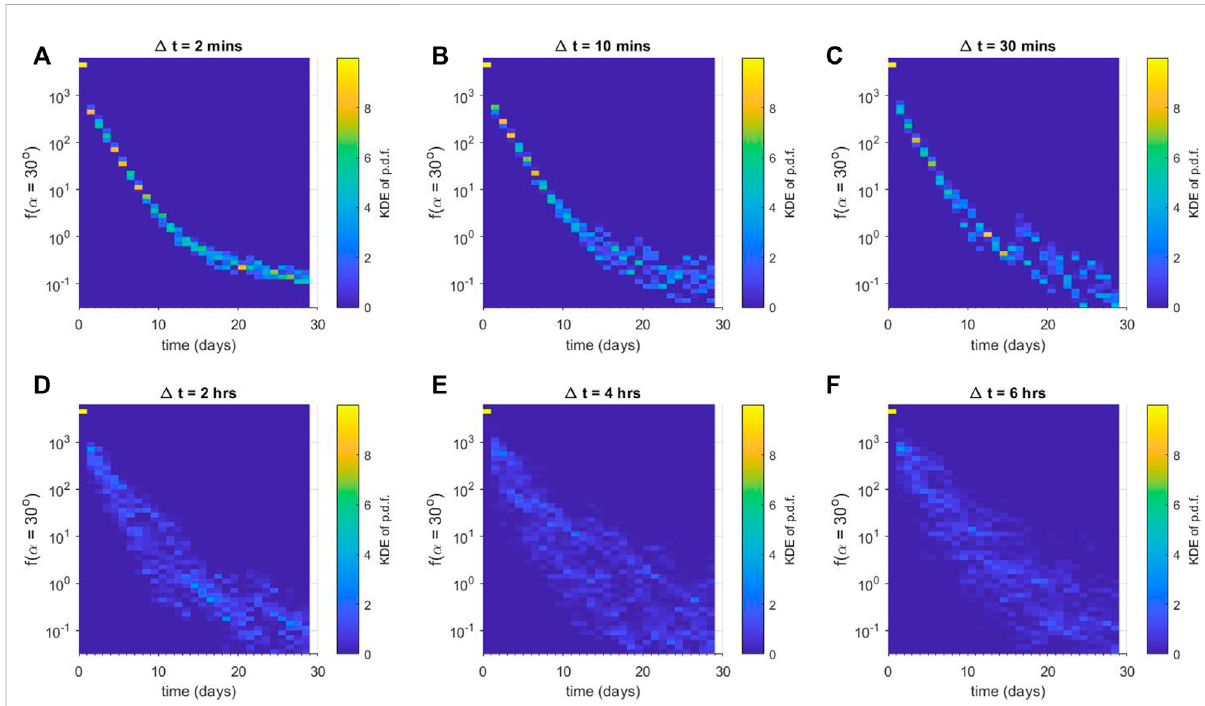
FIGURE 3 Ensembleresultsfornumericaldiffusionexperimentsusing D αα ( L *=3).Eachpanelshowsacolumn-normalisedprobabilitydistributionfunction forthephasespacedensity f justoutsidetheloss-cone α LC for (A) Δ t =2 min, (B) Δ t =10 min, (C) Δ t =30 min, (D) Δ t =2 h, (E) Δ t =4 h,and (F) Δ t =6 h. Note that each histogram is displayed using the same vertical binning, giving the histograms a pixelated